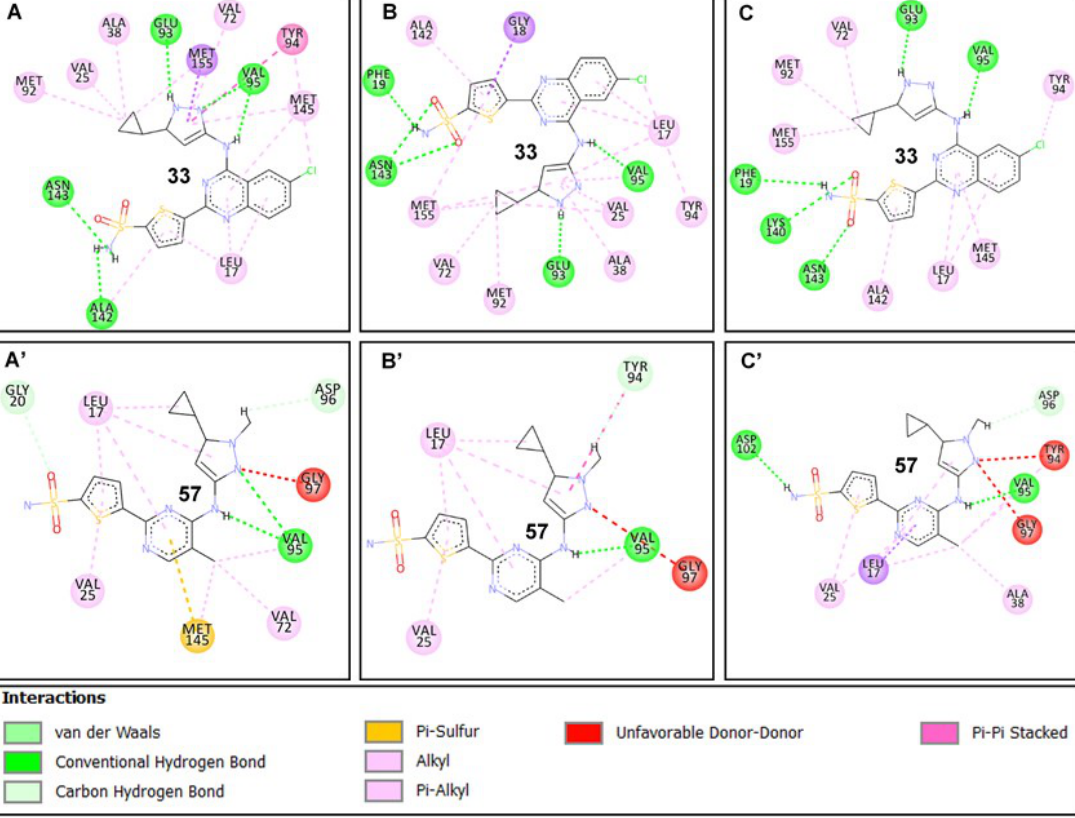
Figure 9. Binding dynamics of compounds 33 and 57 at the NBP of PknB as estimated from the post-equilibrated time frames 170–200 ns. ( A ) 33 -PknB at 170 ns. ( B ) 33 -PknB at 190 ns. ( C ) 33 -PknB at 200 ns. ( A’ ) 57 -PknB at 170 ns. ( B’ ) 57 -PknB at 190 ns. ( C’ ) 57 -PknB at 200 ns. Favorable and non-favorable interactions involved disparately in the binding of 33 and 57 are indicated. Appropriate legends representing each interaction types are also shown.